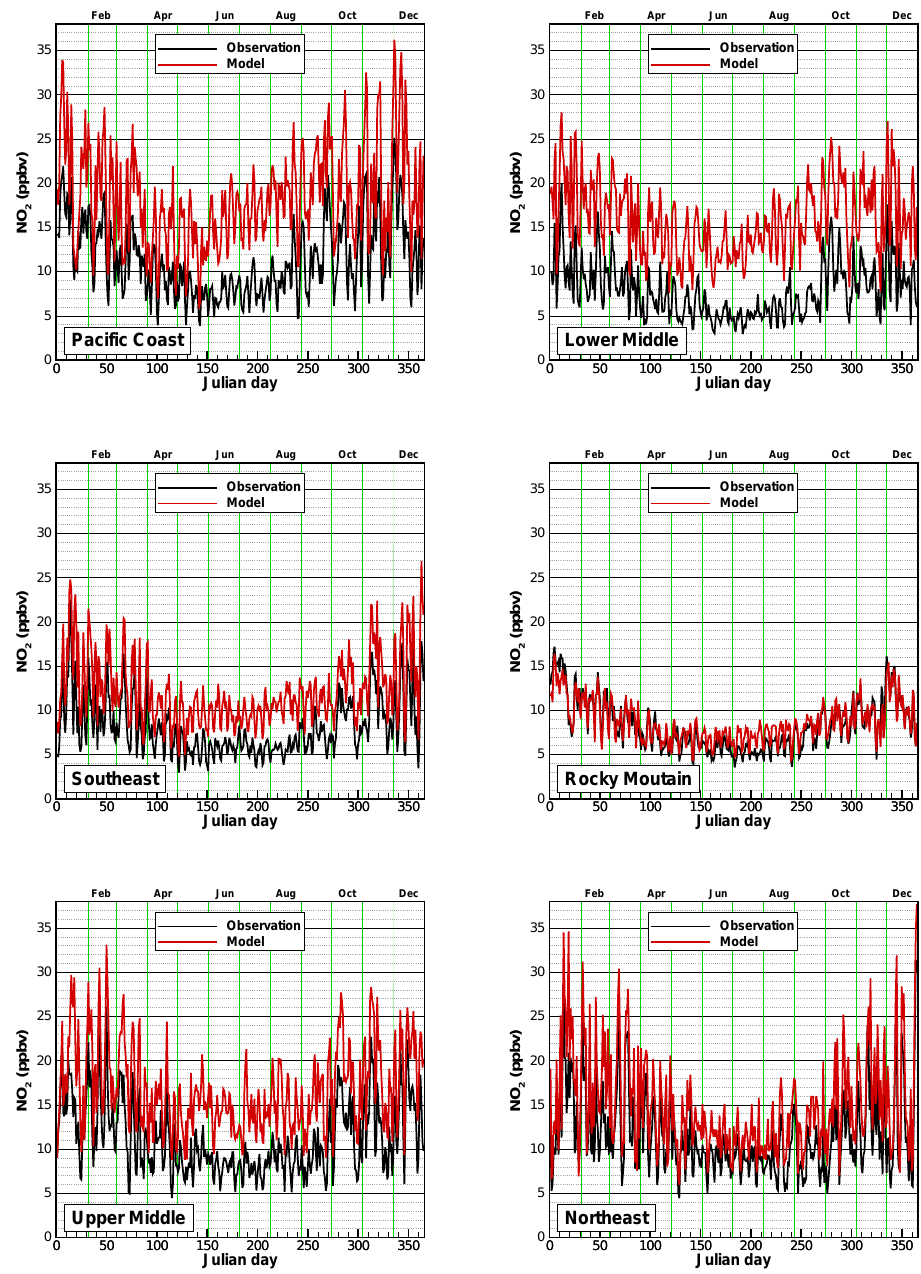
Fig. 7. Daily average AQS (black) and NAQFC NO 2 concentrations in 2010 for each of the six regions listed in Fig. 1.